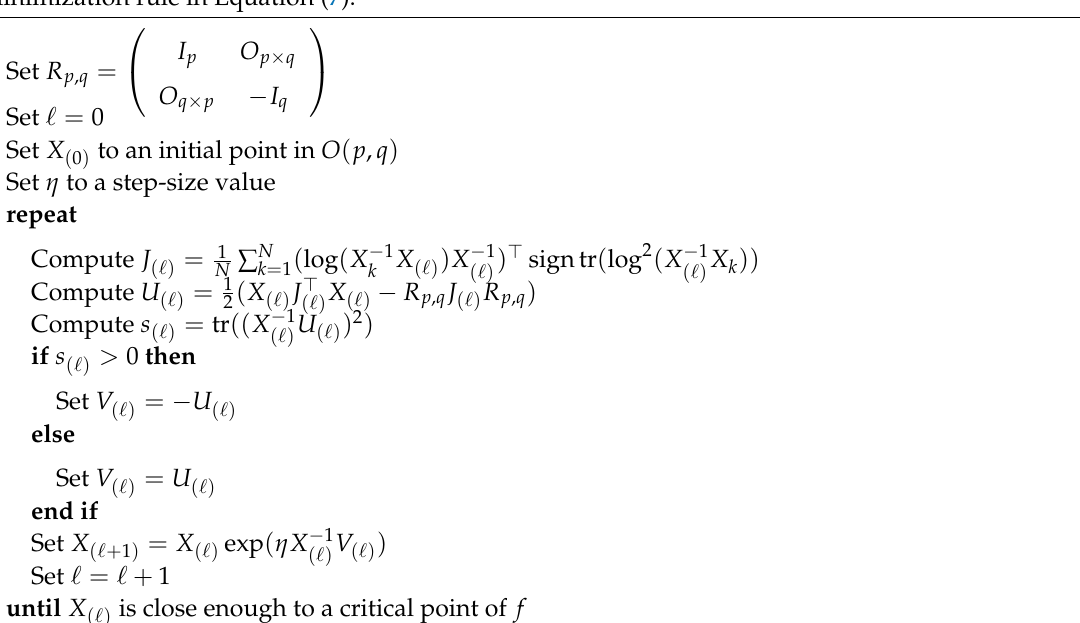
Algorithm 2 Pseudocode to implement mean-computation over O ( p , q ) according to the function minimization rule in Equation